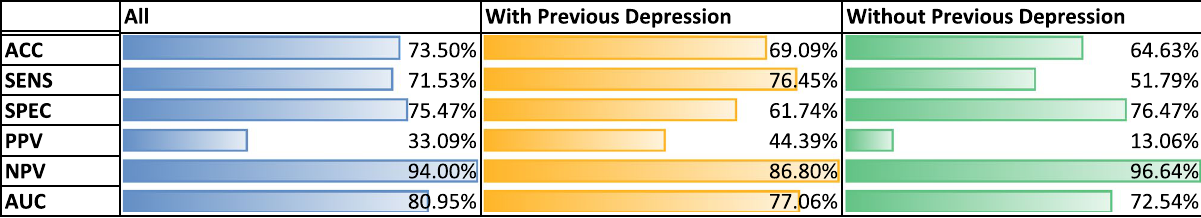
Figure 4. Stratified classification graphs for Extreme Randomized Forest (XRT) model, by pregnancy/previous depression status. Results presented for all women (All, n = 2385, of which 14% had postpartum depression, PPD), women with depression during current pregnancy or earlier in life (With Previous Depression, n = 971, of which 27% had PPD), and women without any previous depression episode (Without Previous Depression, n = 1414, of which 6% had PPD). For each category, models were assessed for accuracy (ACC), sensitivity (SENS), specificity (SPEC), positive predictive value (PPV), negative predictive value (NPV), and area under the curve